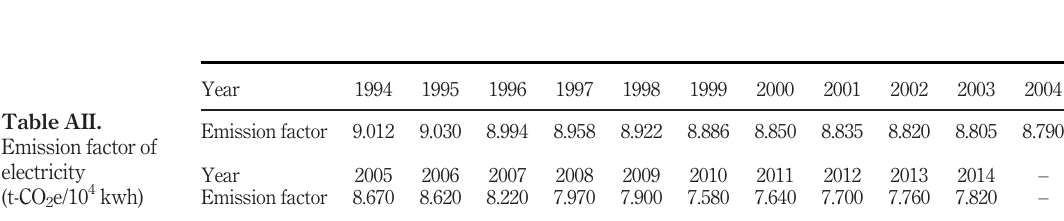
Table AII. Emission factor of electricity (t-CO 2 e/10 4 kwh)